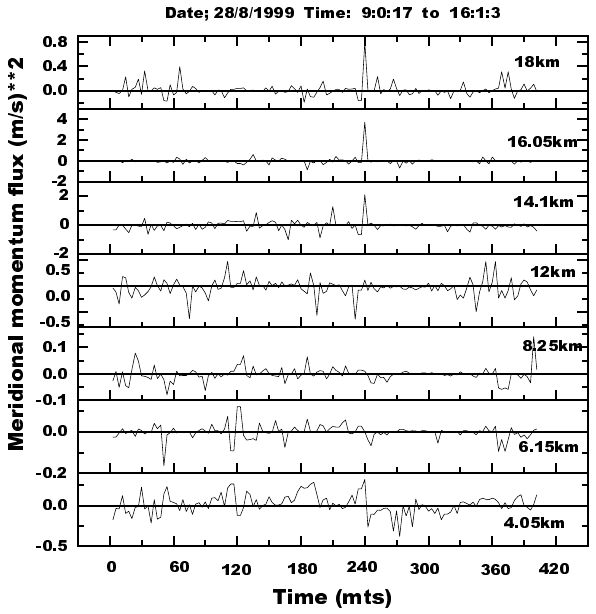
Fig. 13. The average zonal momentum flux during the convection event (full line with error bars) and during a period without convec- tion (dotted line) on 28 August 1999.